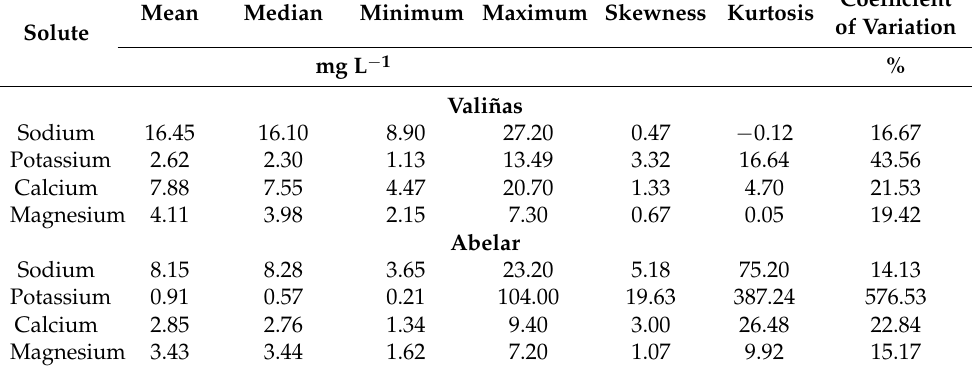
Table 1. Statistical summary of the sodium, potassium, calcium and magnesium concentrations in wa- ter samples from Valiñas and Abelar catchments over the whole study period (2003–2016 for Valiñas and 2007–2016 for Abelar). Number of samples was 984 and 391 in Valiñas and Abelar, respectively. Coefficient Mean Median Minimum Maximum Skewness Kurtosis of Variation Solute mg L − 1 % Valiñas